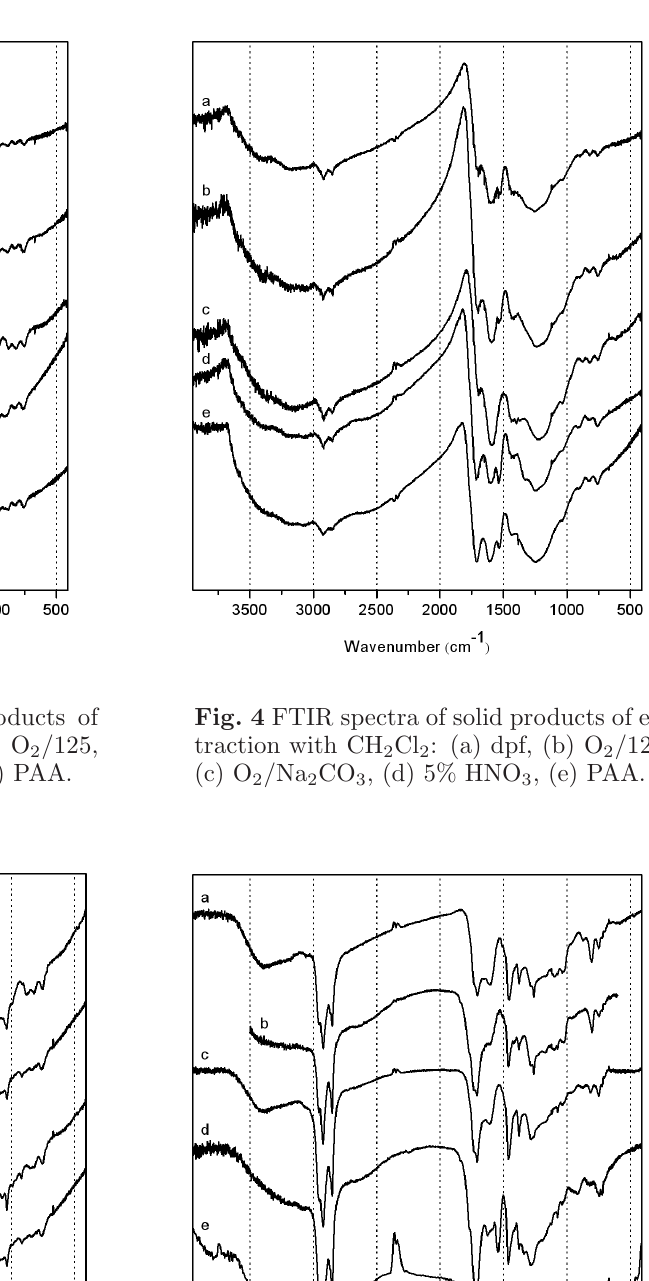
Fig. 5 FTIR spectra of THF extracts: (a) dem, (b) O 2 /125, (c) O 2 /Na 2 CO 3 , (d) 5% HNO 3 , (e) PAA.